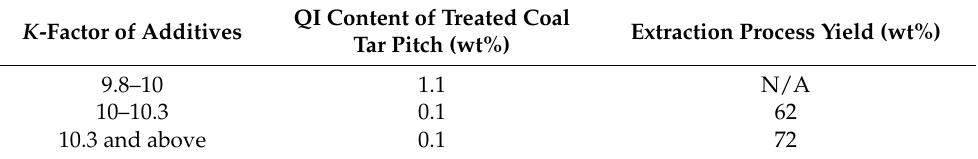
Table 2. Quinoline insoluble (QI) content of treated coal tar pitch by extraction combined with various